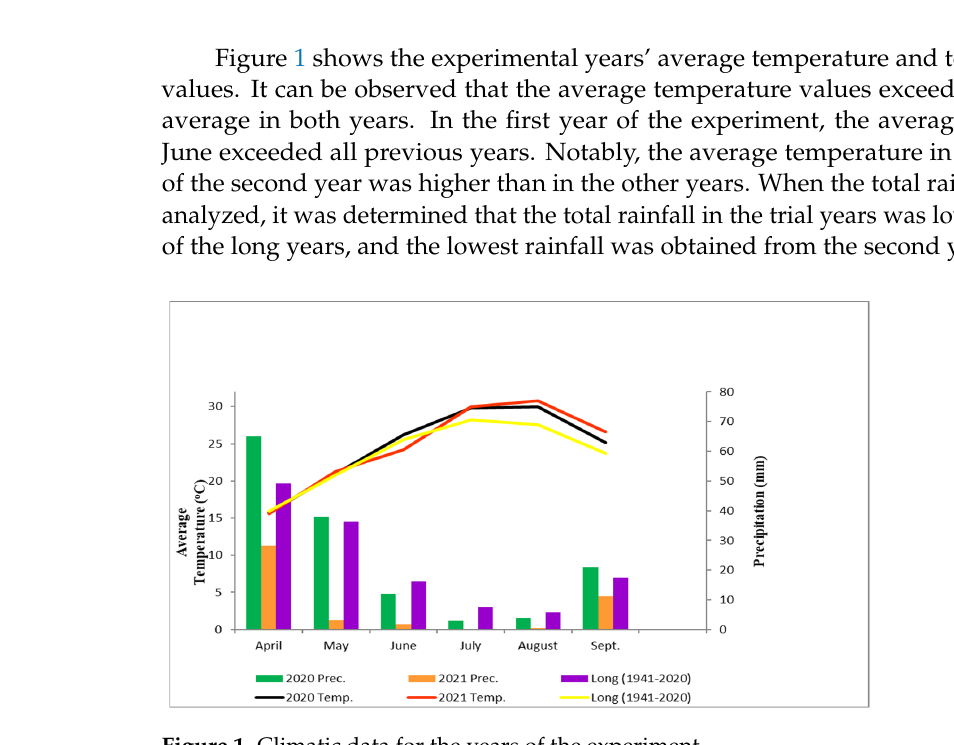
Figure 1. Climatic data for the years of the